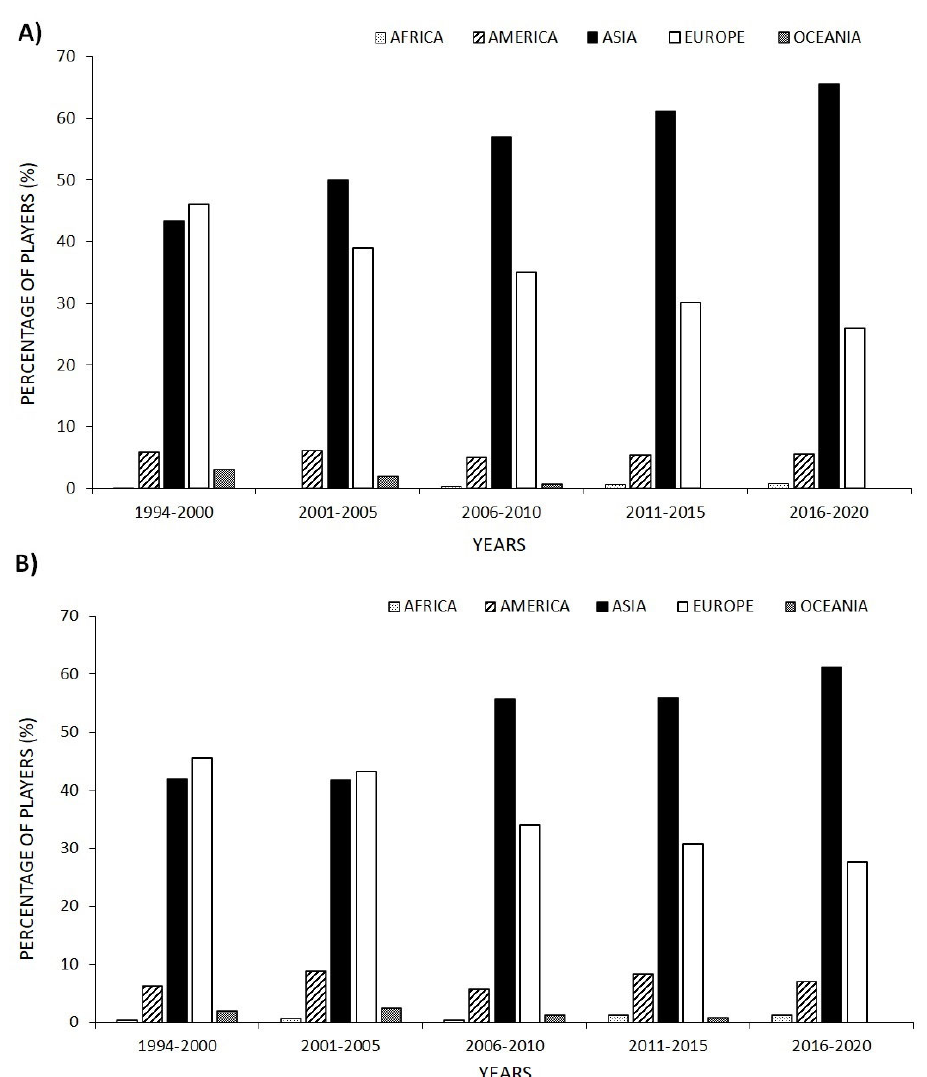
Figure 4. Percentage of players from each continent in the World Ranking top 100 (both men ( A ) and women ( B )).